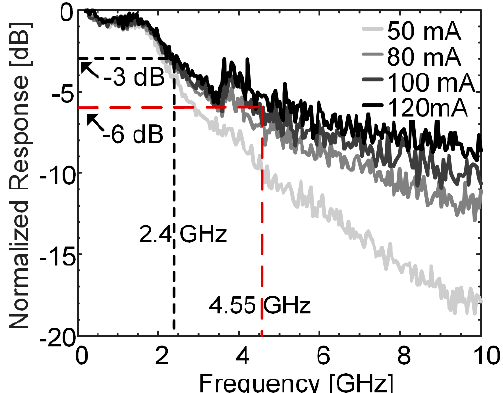
Figure 5. Measured small signal modulation frequency response of an RSOA at 50–120 mA bias currents. The modulation bandwidth increases with bias current. At 100 mA, the RSOA has − 3 and − 6 dB bandwidths of 2.4 and 4.55